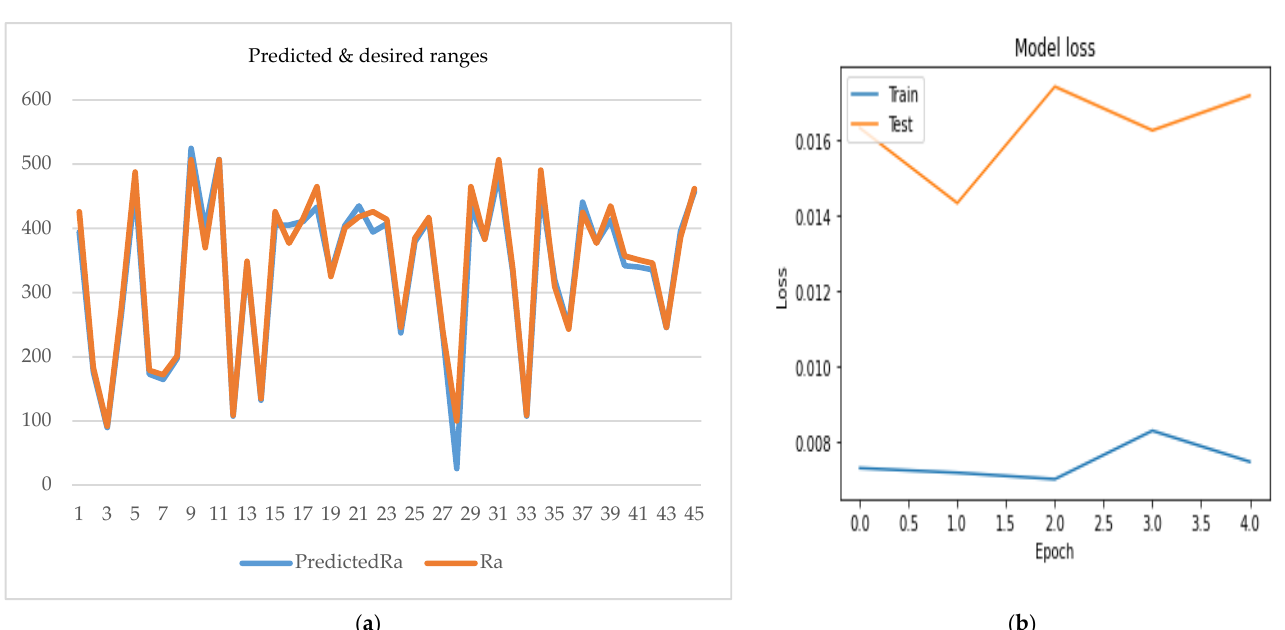
Figure 14. Predicted range analysis. ( a ) Behaviour of the predicted range; ( b ) Model loss with increase in epoch.